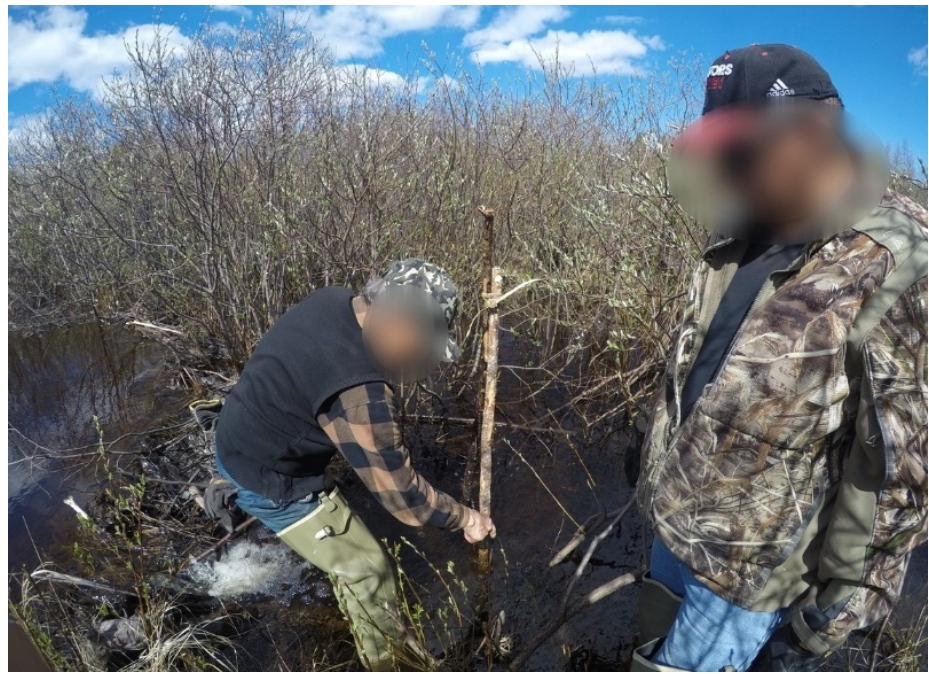
Figure 9. An Elder and on-the-land expert setting a beaver trap prior to removing the dam. Although many of the benefits were recognized, the participants also recognized the trauma and other barriers which were stopping them from participating in the on-the- land activities prior to this program,